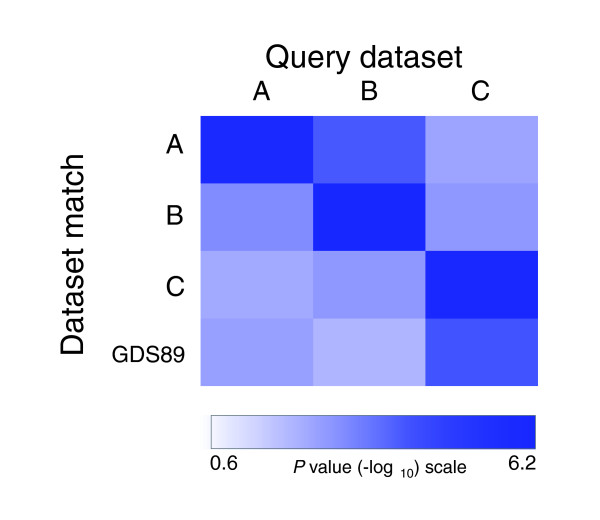
Cross-platform dataset matching revealed by EXALT. Heat-map illustrating the statistical significance among NCI-60 gene expression profiling experiments. The datasets include those reported by Staunton and coworkers [13] (dataset A), Butte and colleagues [12] (dataset B), Ross and coworkers [14] (dataset C), and GDS89. Datasets A and B were generated using Affymetrix arrays, whereas datasets C and GDS89 were generated using spotted cDNA arrays. Dataset comparisons exhibited adjusted mean P values below 0.01 (corresponding to values > 2.0 on the -log10 scale). The greatest significance levels were observed for self-matching and matches between studies using the same microarray platform. EXALT, EXpression signature AnaLysis Tool; GDS, Gene Expression Omnibus dataset.